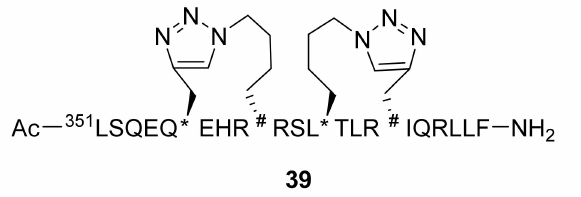
Figure 18. Stapled peptide targeting the β -catenin/BCL9 interaction. * indicates L -amino acid, and # indicates D -amino